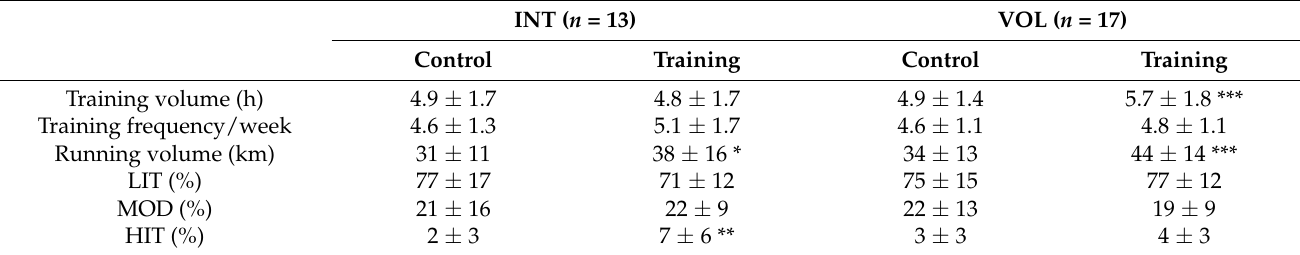
Table 2. Average weekly training characteristics during the control and experimental training